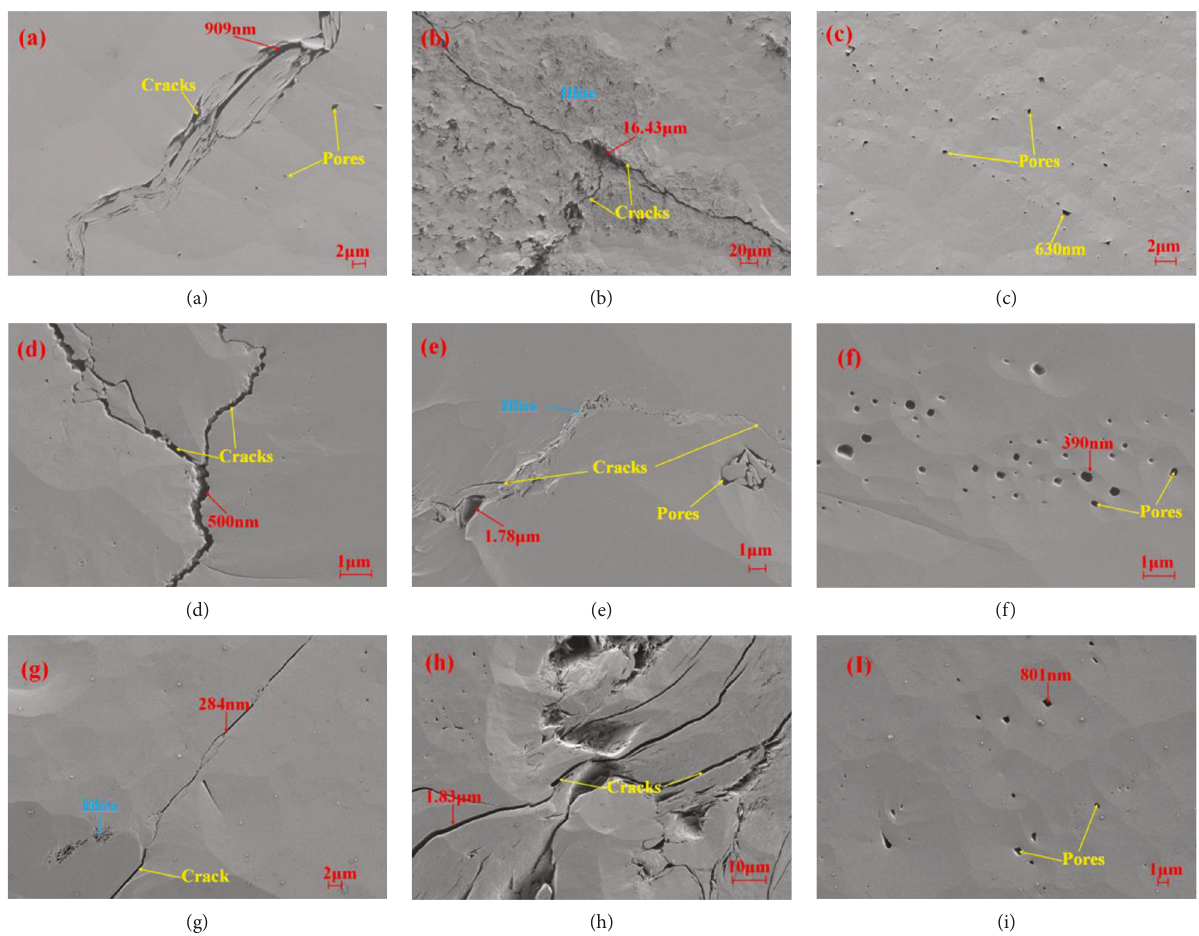
Figure 9: The SEM picture: (a) – (c) belong to M47-3, (d) – (f) belong to S133-4, and (g) – (i) belong to